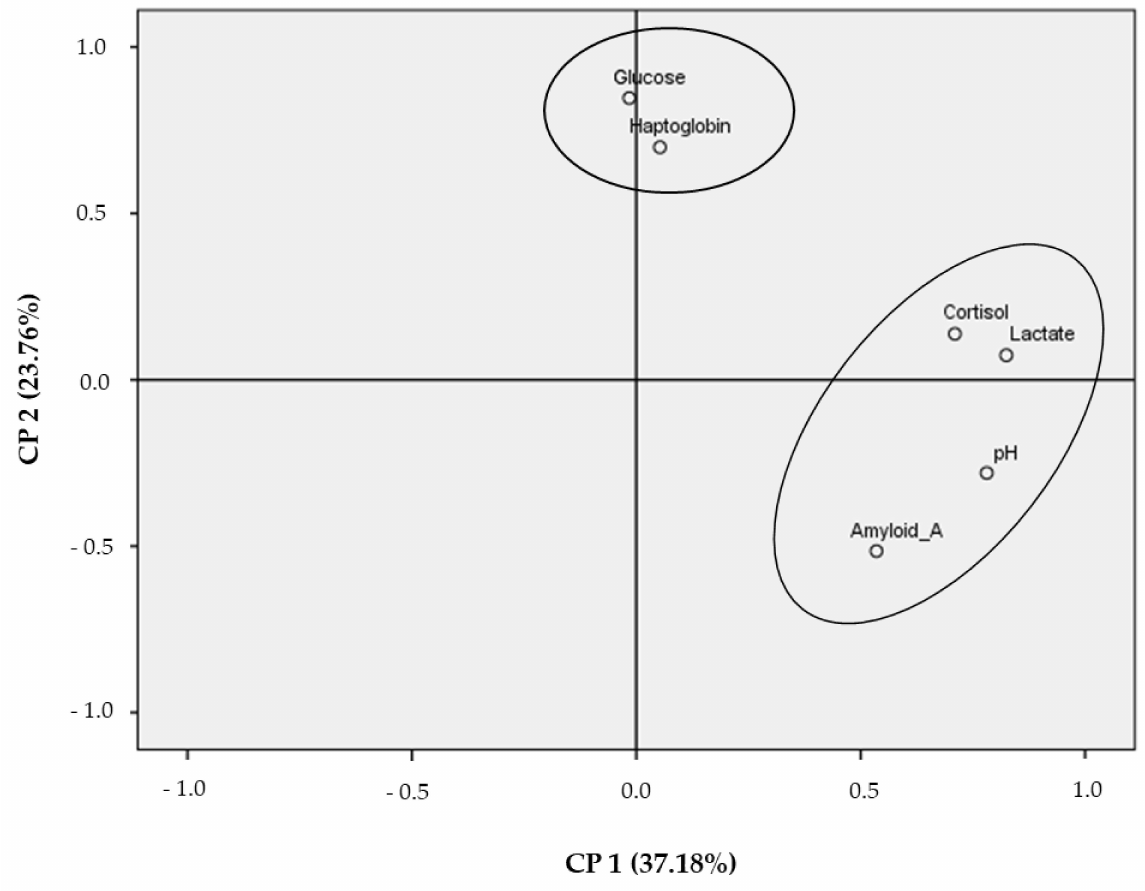
Figure 3. Loading plots for the first two principal components of serum biomarkers at slaughtering time and the pH u of meat, using cortisol, lactate, pH u , and serum amyloid A (PCA1) and serum amyloid A ( − ), glucose, and haptoglobin